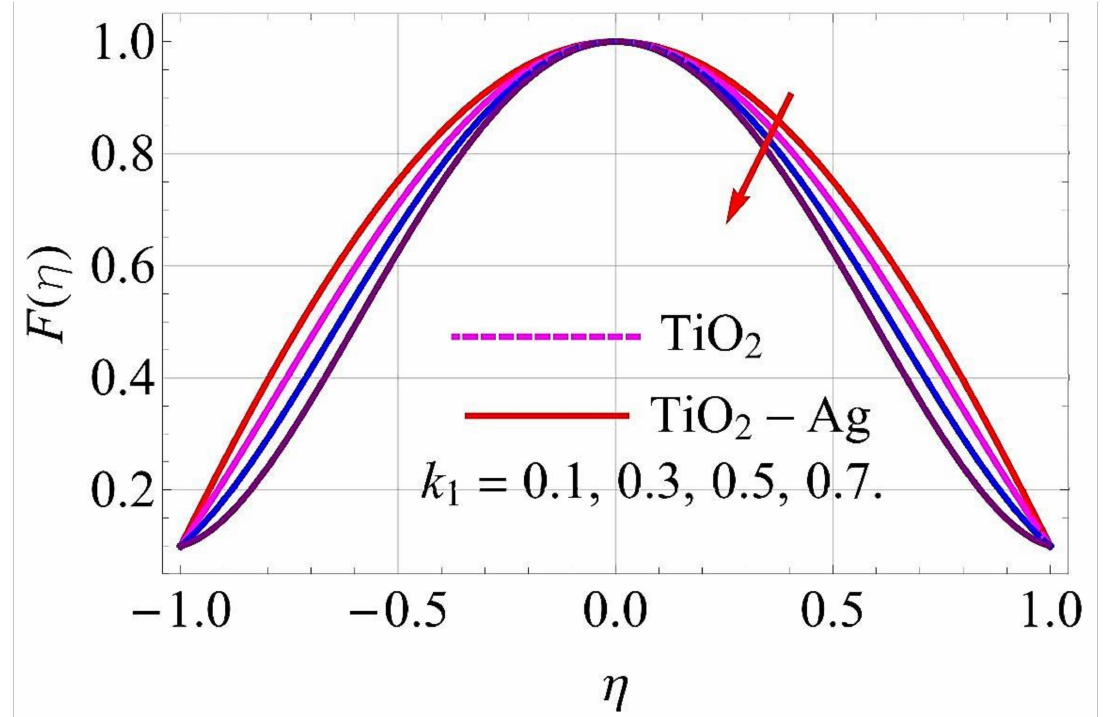
Figure 8. Velocity versus k 1 with α = 5 ◦ for diverging/shrinking circumstances. When Re = 25, φ 1 = φ 2 = 0.01, Rd = 0.4, Ec = Q = Fr = k ∗ = Ha =